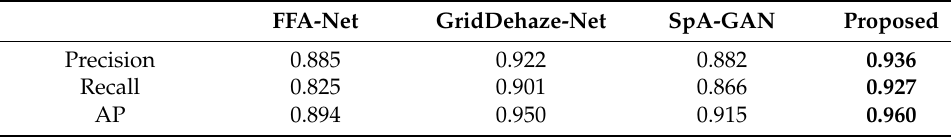
Table 6. Comparison of each model on the low-level noisy image.